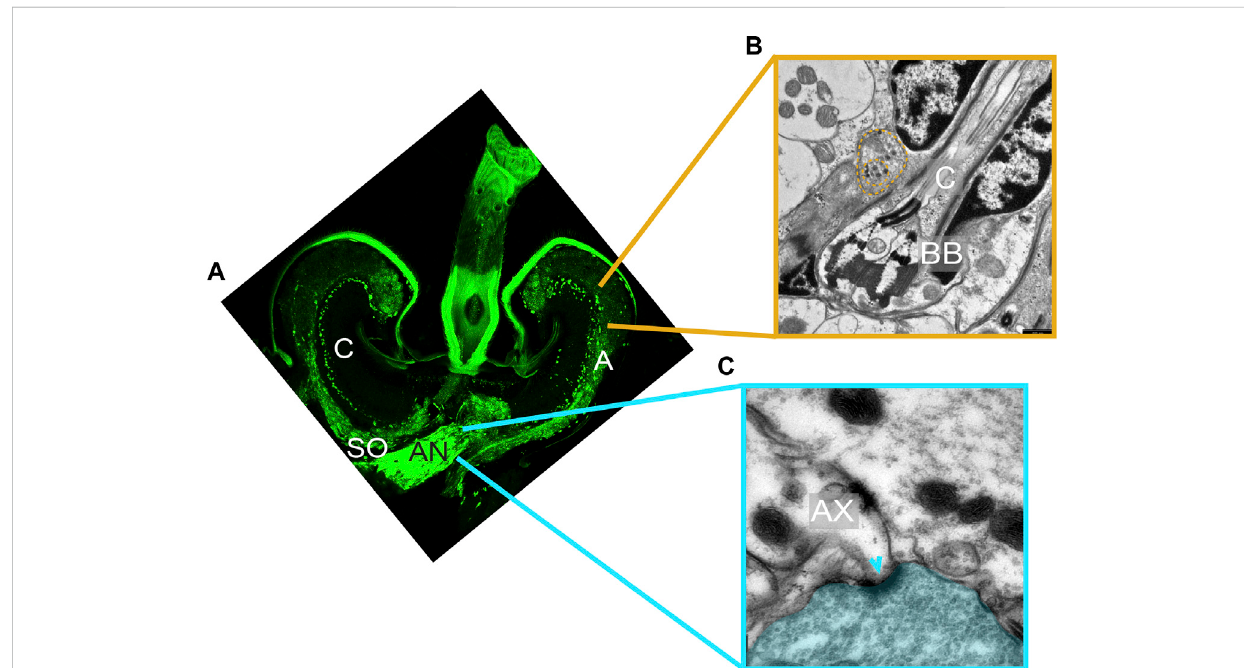
FIGURE 2 Ultrastructure of auditory efferent terminals. (A) Immunostaining of a male JO labelling the presynaptic protein synapsin (mAb 3C11, anti-synapsin, green) suggesting the presence of presynaptic terminals within the male JO. Modi fi ed from Andrés et al. (2016). (B,C) Transmission electron microscope images corresponding to distinct sections of a male Cx. quinquefasciatus JO. (B) Ciliary base region, showing a terminal fi lled with DCVs (yellow dashed line) located in close proximity to the neuronal membrane around basal bodies. (C) Auditory nerve region depicting two axons and an adjacent efferent fi bre fi lled with SVs (blue area). A clear synaptic specialization in the postsynaptic axon can be visualized (arrowhead). AN: antennal nerve; AX: afferent axons; BB: basal body; C: auditory cilia; SO: